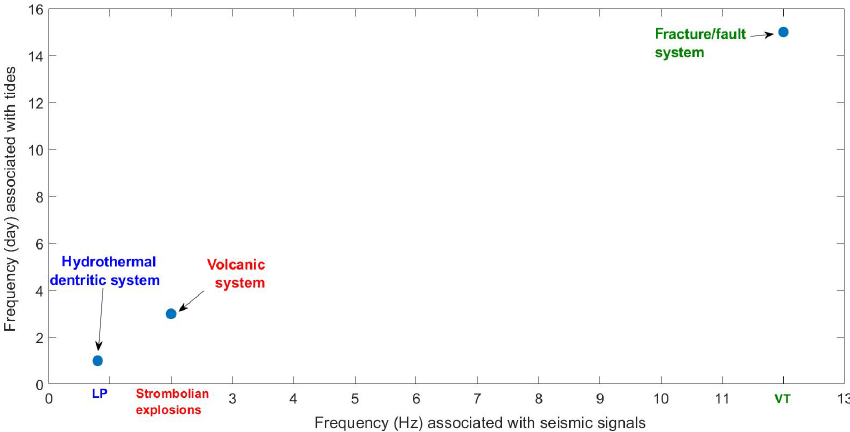
Figure 7. Relation between the tidal periods and the typical frequencies related to the kind of events on that scale and involved system.